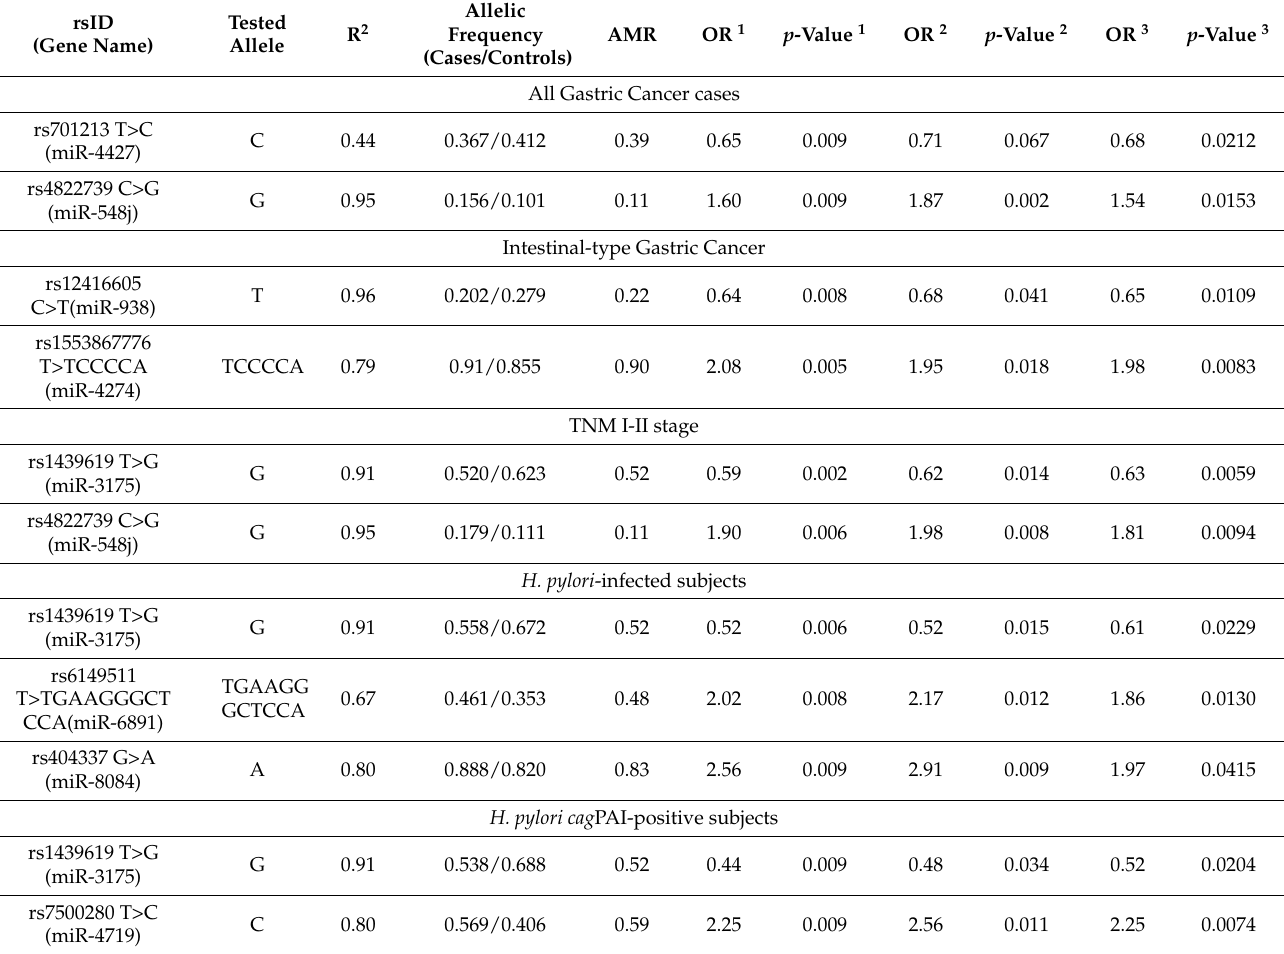
Table 2. Genetic polymorphisms associated with gastric cancer with the smallest p-value by allele